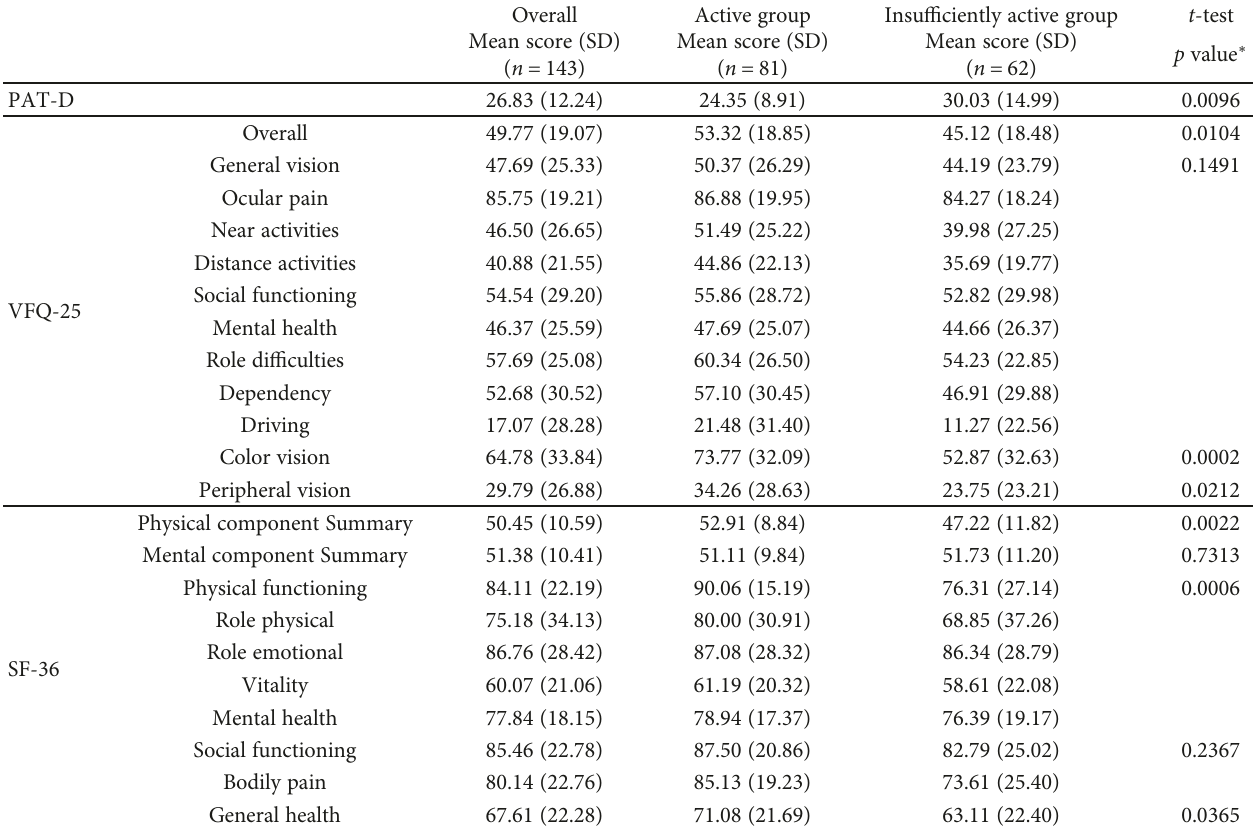
Table 2: Relationship between quality of life survey scores and exercise